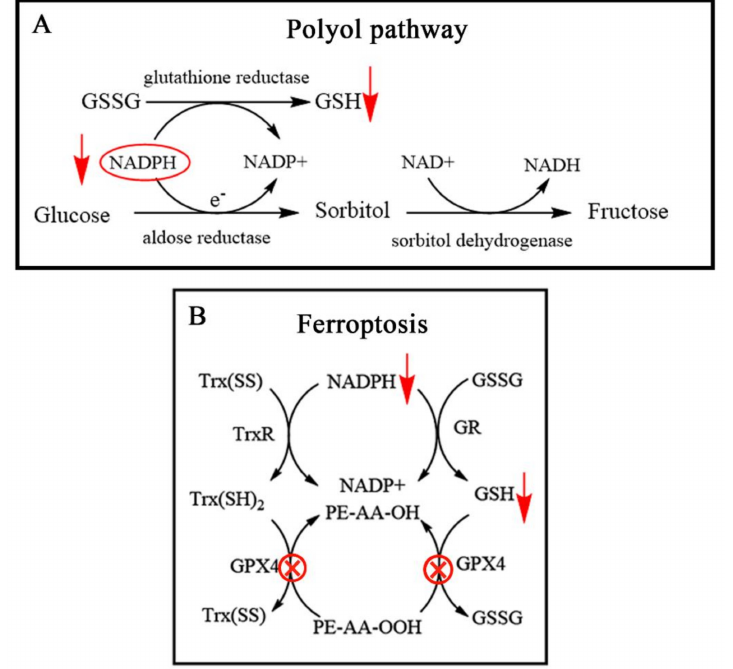
Figure 3. Pathogenesis of GSH involved in: ( A ) mechanism of polyol pathway [21]; ( B ) mechanism of ferroptosis